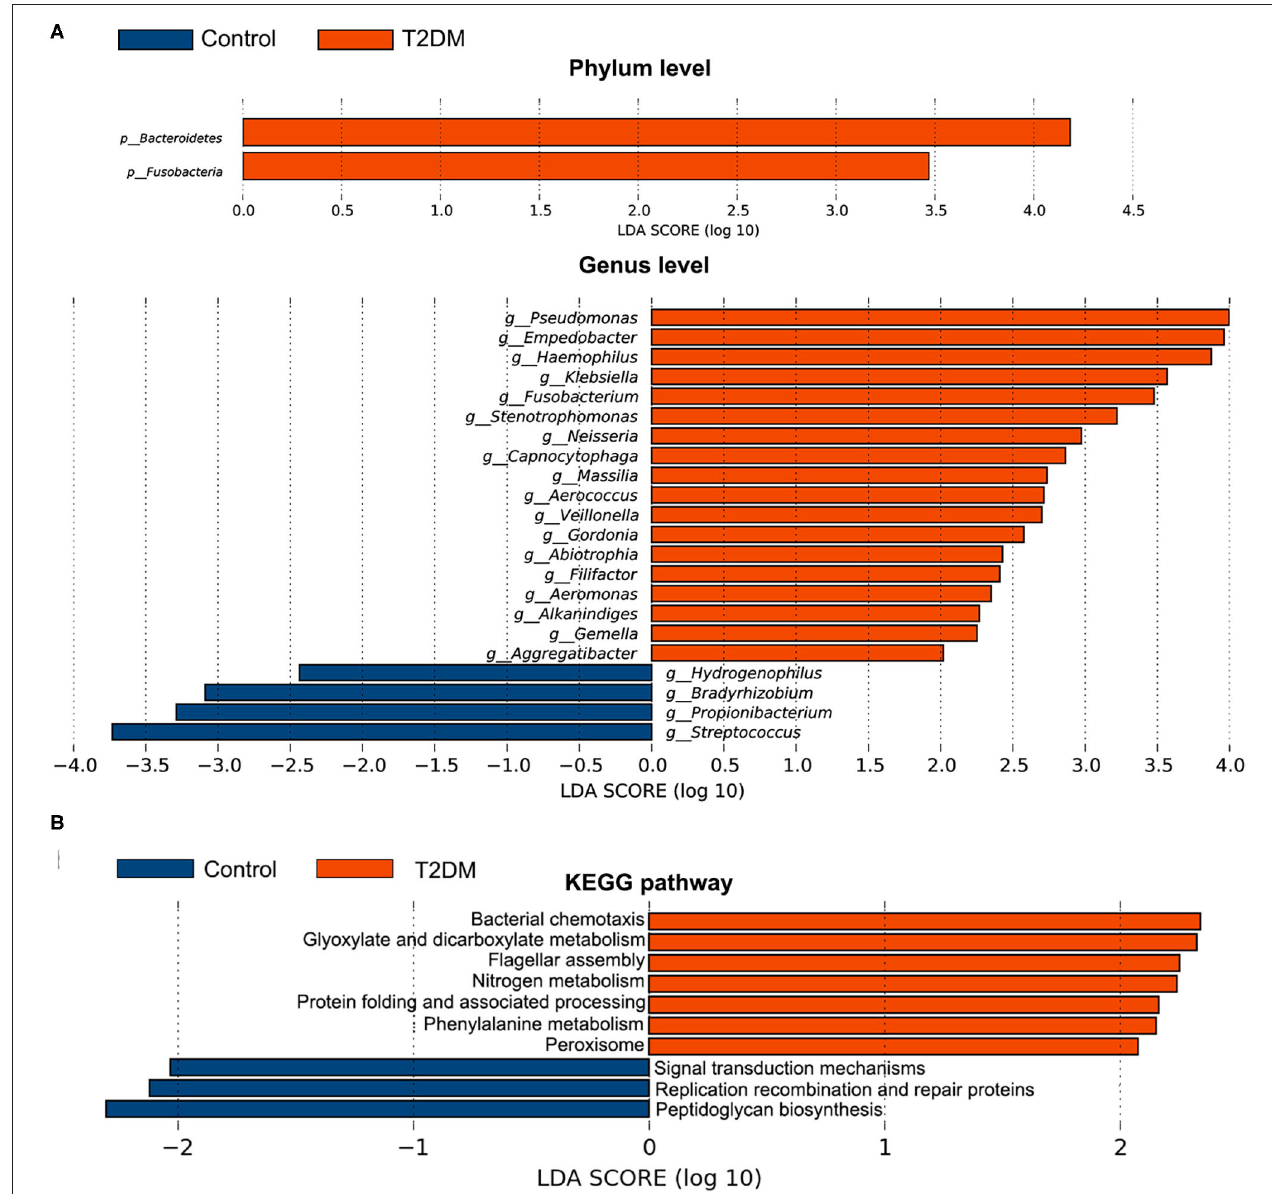
FIGURE 3 | Comparative analysis of the conjunctival microbiota and the KEGG pathways between the control group and T2DM group. Bars represent linear discriminant analysis scores (LDA) based on LEfSe results. (A) The taxa with different relative abundance at phylum and genus levels. (B) The different KEGG pathways. Positive LDA score means enriched taxa or metabolic pathways in T2DM patients, while negative score means in the